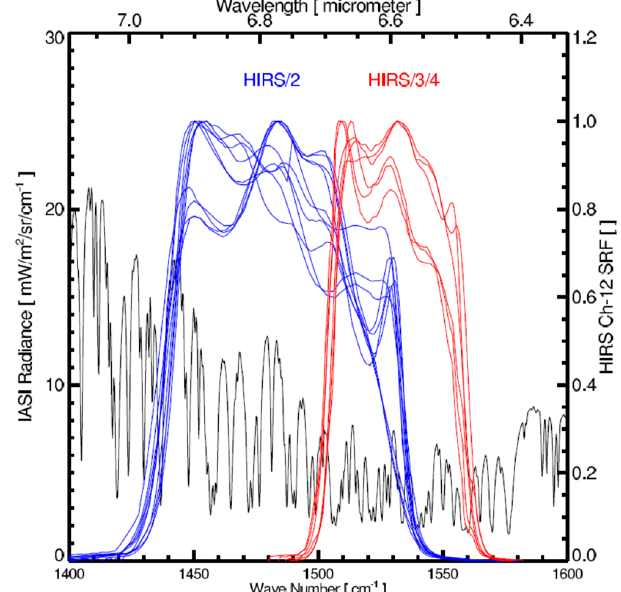
Figure 2. Spectral response functions of HIRS/2 (blue), HIRS/3 (red) and HIRS/4 (red) instruments for the Channel 12 ( ≈ 6 µm). IASI spectra (black) are also shown to illustrate atmospheric opaqueness for these spectral regimes. The approximate spectral ranges for the HIRS/2 series and the HIRS/3 and HIRS/4 series are marked at the top, which clearly indicates a spectral shift between the generations. Satellites carrying HIRS/2 instruments are TIROS-N and NOAA-6 through NOAA-14. Satellites carrying HIRS/3 instruments are NOAA-15 through NOAA-17. Satellites carrying HIRS/4 instruments are NOAA-18, NOAA-19, Metop-A and Metop-B.